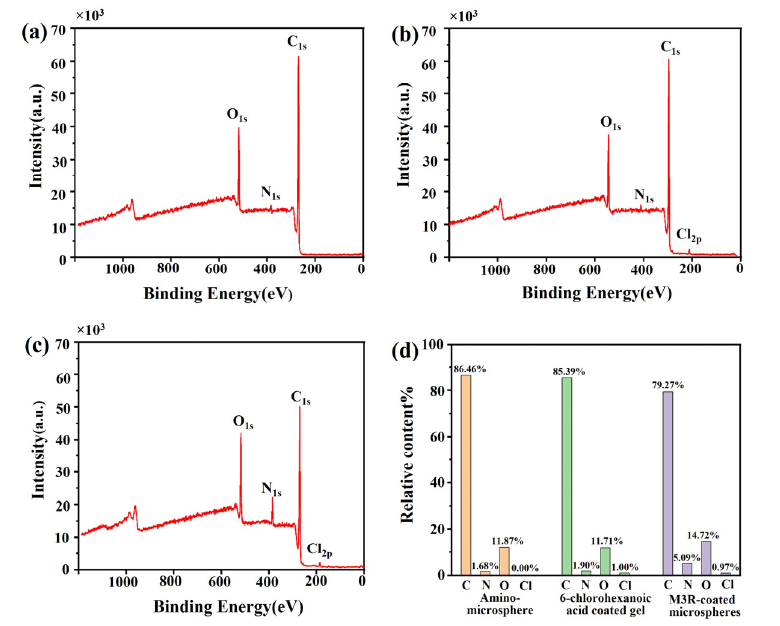
Figure 2. The element characterization of amino microspheres by X-ray photoelectron spectroscopy. The images show the element characterization of amino microspheres ( a ), 6-chlorohexanoic-acid-coated microspheres ( b ), and M3R-coated microspheres ( c ) by X-ray photoelectron spectroscopy ( d ). The percentage distribution of the elements C, N, O, and Cl in the amino microspheres, 6-chlorohexanoic-acid-coated amino microspheres, or M3-receptor-coated amino microspheres are calculated.